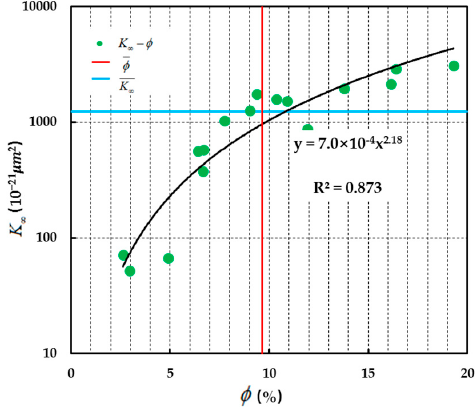
φ . φ . Figure 15. The relationship between K ∞ and φ